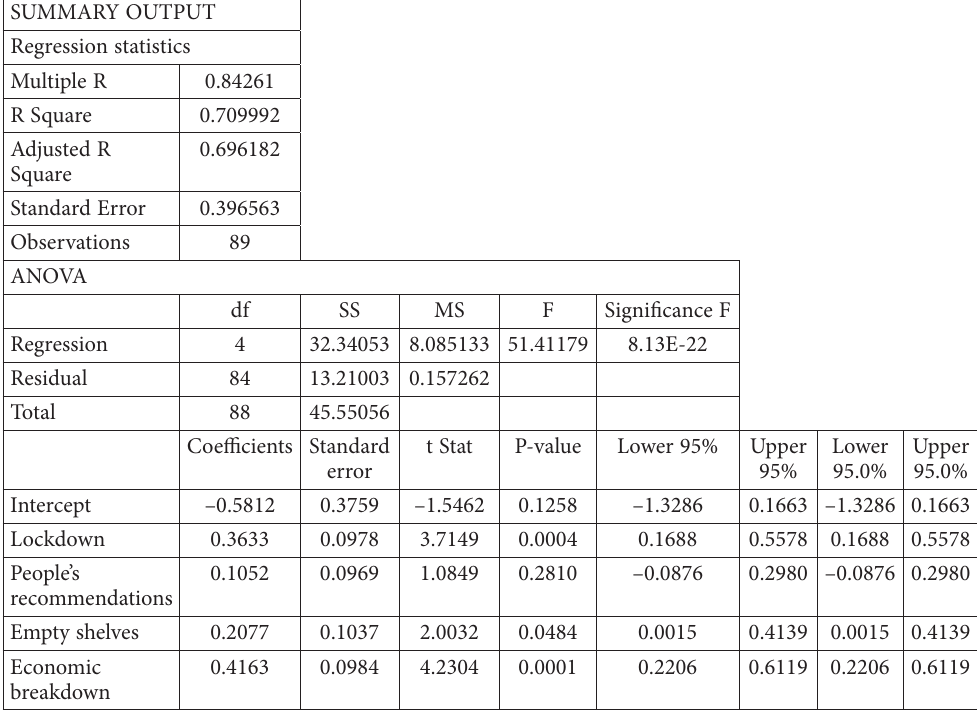
Table 3. Results of multi-variant regression (source: prepared by